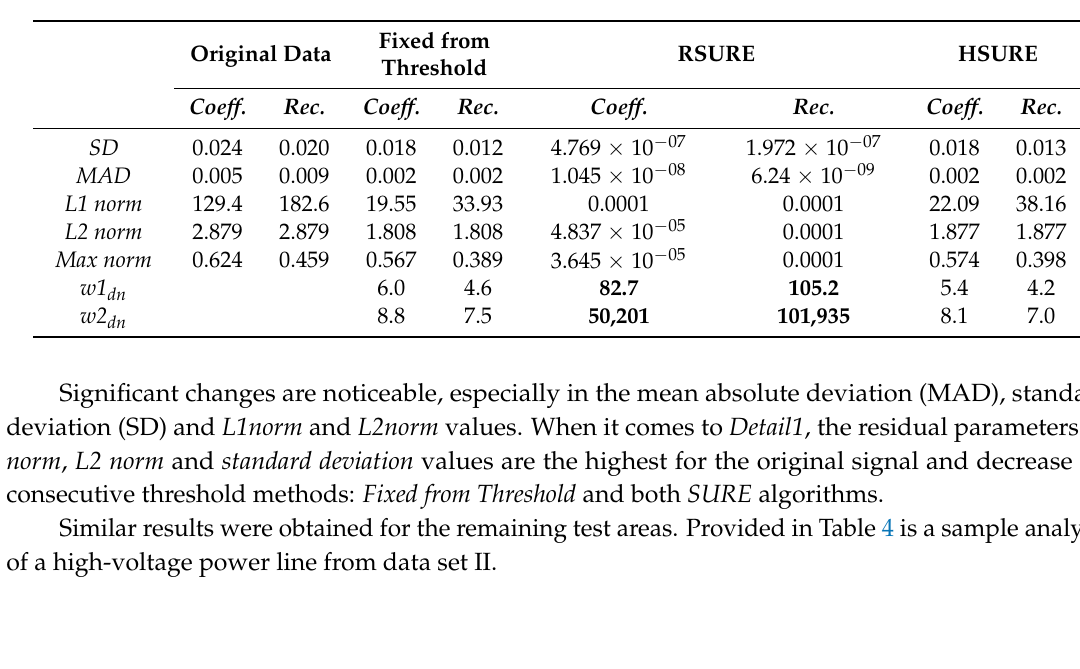
Figure 17. High-voltage power lines from UAV multi-images ( a ) lines and towers before and after intensity filtering, ( b ) lines before and after filtering.